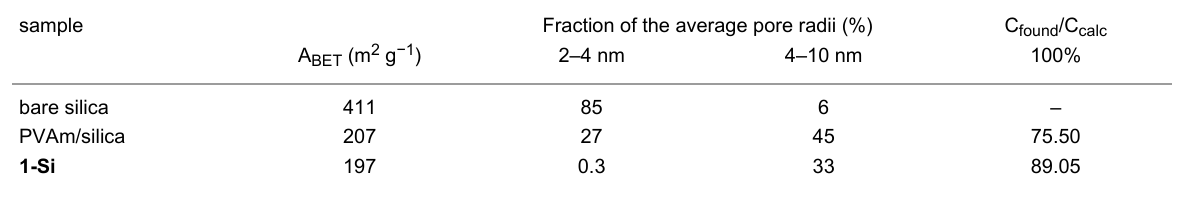
Table 1: Specific surface areas (according to BET, A BET ) and fractions of the average pore-size radii range of the bare silica support, a PVAM/silica hybrid material and 1-Si , compared with the relative carbon-content (C found /C calc ·100%) determined from data of the elemental analysis. sample